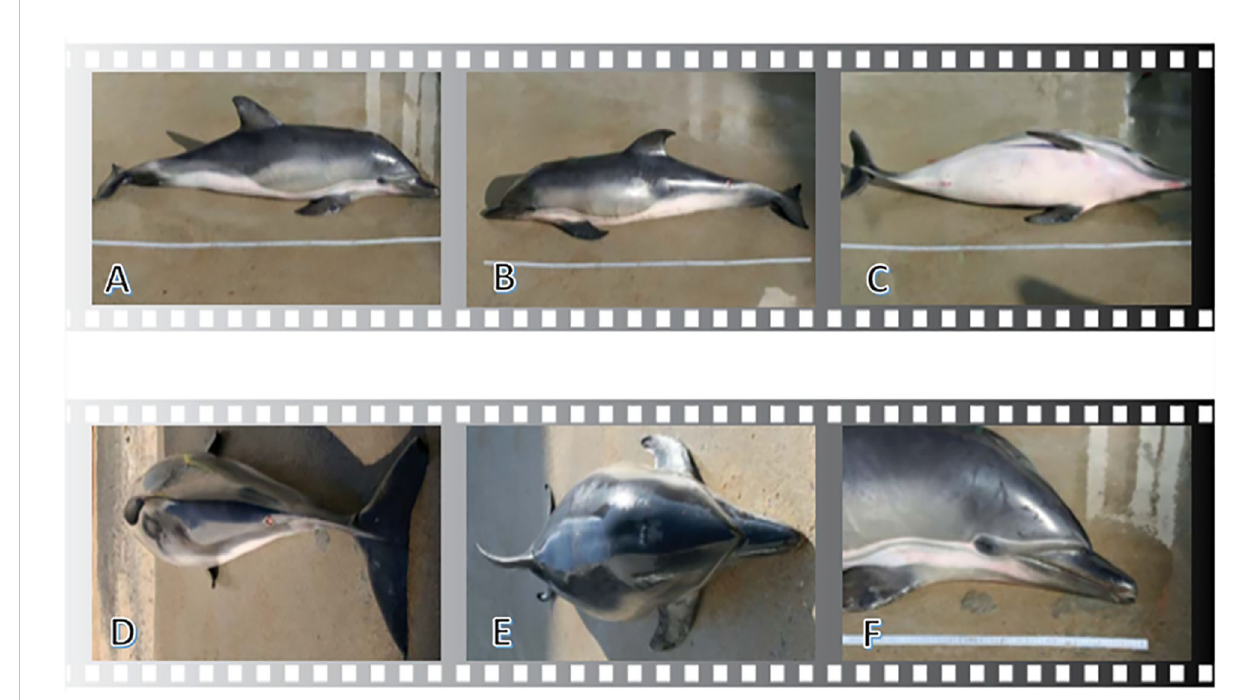
FIGURE 2 The six standardised photos, © PELAGIS. (A) Lateral right view; (B) Dorsal view; (C) Ventral view; (D) Rear view; (E) Front view; (F) Head